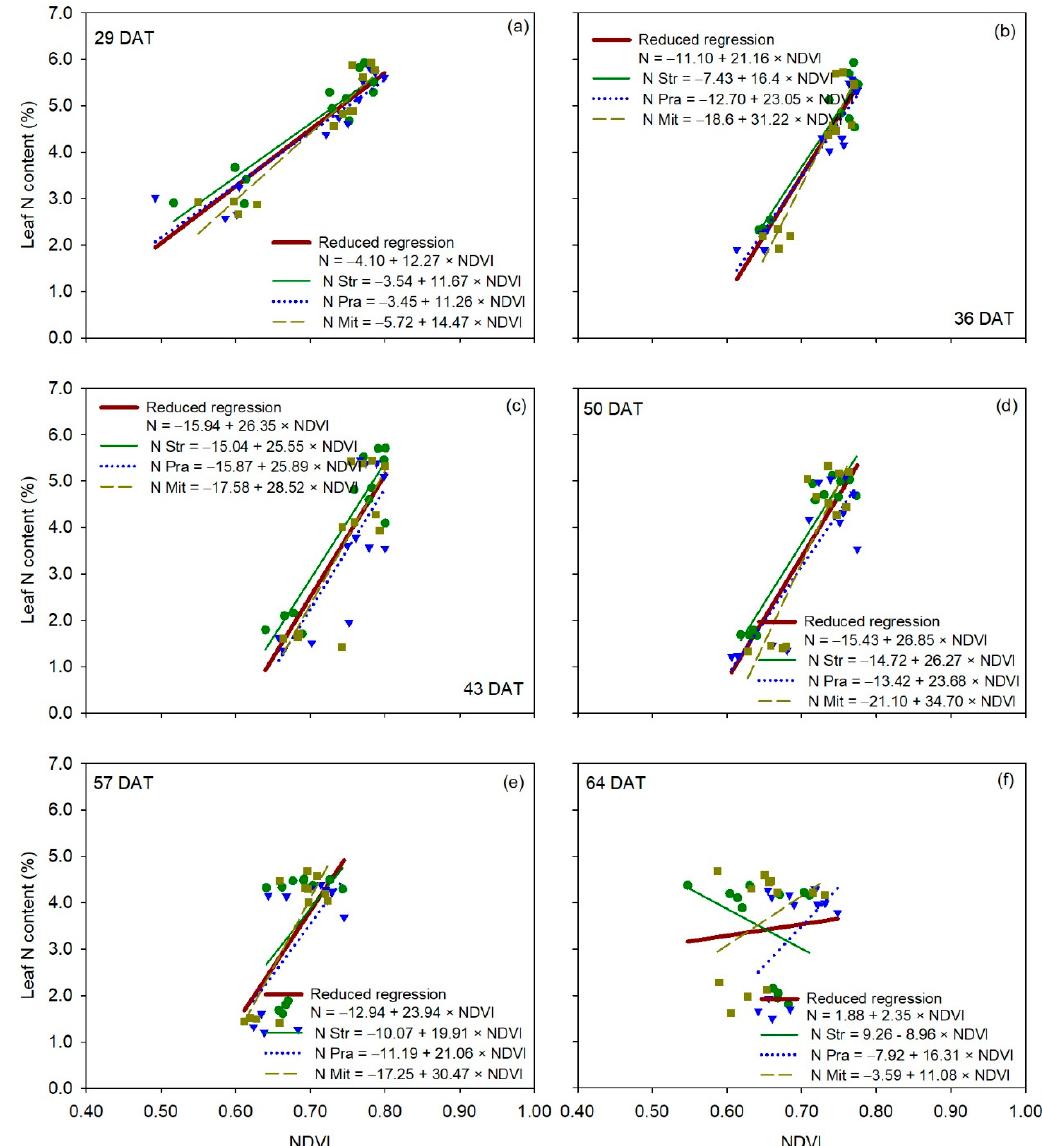
Figure 7. Linear regression between NDVI measurements (independent variable) and leaf N content (dependent variable) for each cultivar of cucumber ( Cucumis sativus L.), for each measurement date (panels a – f ). The reduced regression is a regression with data of all three cultivars together. DAT is days after transplanting. Str, ‘Strategos’, Pra, ‘Pradera’, Mit, ‘Mitre’